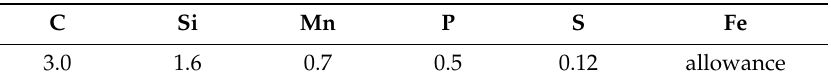
Table 1. Composition of the cast iron (wt